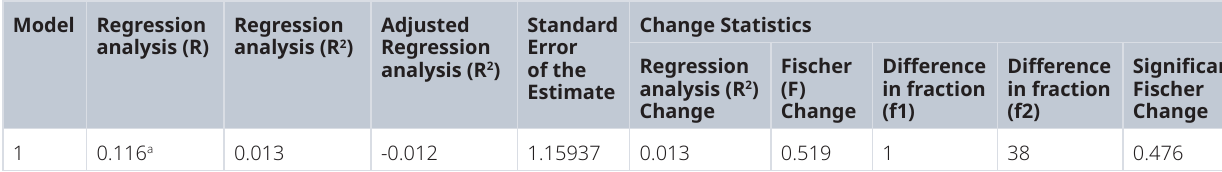
Table 2a. Model Summary.